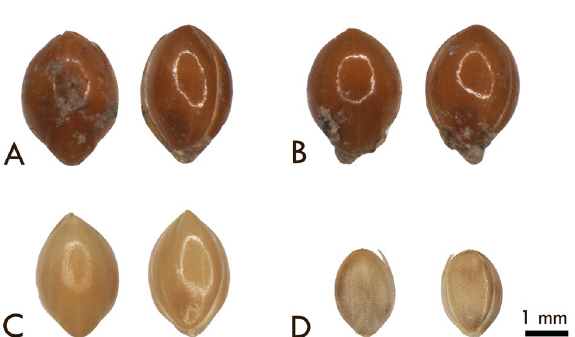
Figure 2. Areni-1 and modern millet grains. Paired photographs of 4 different grains in dorsal (left) and ventral (right) views depicting ( A and B ) representative archaeological Panicum miliaceum florets from Areni-1; ( C ) modern comparative P. miliaceum subsp. miliaceum floret (USDA PI 170588, Turkey); and ( D ) modern comparative Setaria italica subsp. italica floret (USDA PI 173103, Turkey). NPGS: U.S. National Plant Germplasm System (https:// www. ars- grin. gov/ npgs/ index.